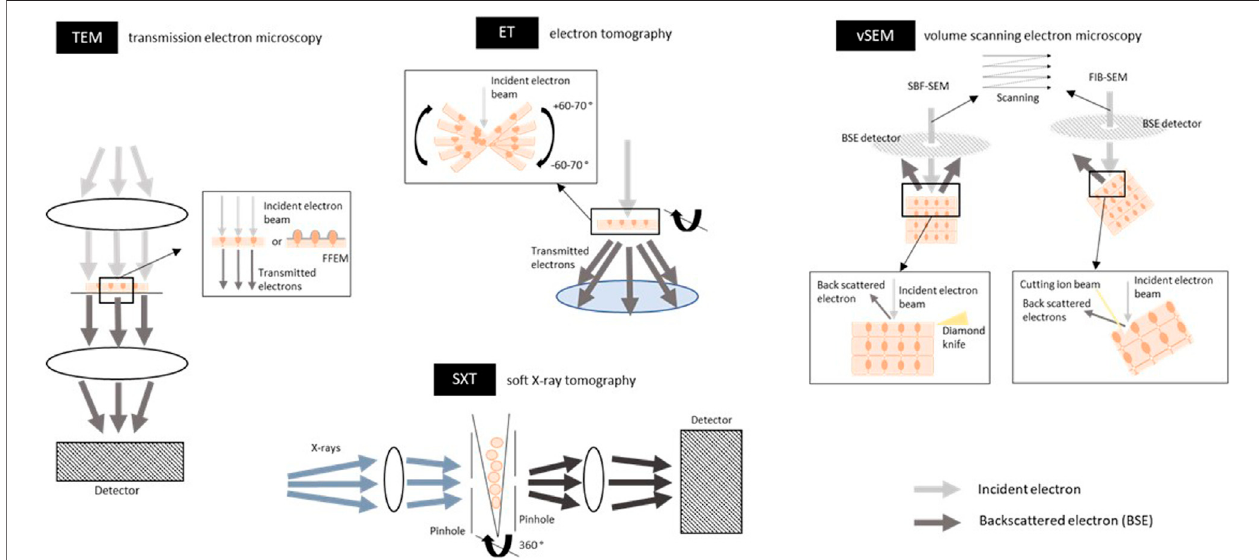
FIGURE 6 | Schematic overview of electron and X-ray based techniques for imaging the tight junctions, adherens junctions and desmosomes. Transmission electron microscopy (TEM) uses an electron beam that passes through the sample (thin sections of 60 – 80 nm of tissue or cultured cells; either fi xed or cryo-frozen because of vacuum conditions). The electron beam is absorbed and scattered by the sample which in their turn are captured on a detector and a contrast image of the sample can be seen. Electrons can only penetrate a very thin sample. In freeze fracture EM (FFEM) frozen biological samples are physically broken apart and platinum-carbon is used to replicate and contrast the fracture plane, which is then analyzed by TEM, exposing the intercellular junctions between cells. The lateral (xy) resolutionis2 nm.Foranexample ofanimage, see Figure4A .Electron tomography(ET)isanEM-derivedtechnique and isbasedonatiltseries of2Dimages acquired at different viewing angles, which are subsequently aligned and combined digitally into a 3D volume. Tilt series contain projections from a complete ±60 – 70 ° rotation of theobjecttoincludeprojectionsfromallpossibledirections.Thisgivesa3Dviewthroughthedepthofthespecimenatahighresolutionandtheintercellularjunctionscan bereconstructedin3D.Thesamplemustbethinsections(tissueorculturedcells;limitedtoabout300 nm; fi xedorcryo-frozen)torenderthemelectrontransparent.The lateral (xy) resolution is 2 nm. For an example of an image, Figure 4B . Volume scanning electron microscopy (volume-SEM) can image larger volumes with a greater sample depth compared to ET. The technique is based on the alternation between scanning the tissue surface with a focused electron beam followed by cutting off a section of the en-bloc tissue. The electron interact with the tissue surface and the backscattered electrons (BSE) are then detected by a detector. Cutting the section is donebyeitheradiamondknife[serialblockface(SBF)-SEM]oranionbeam[focusedionbeam(FIB)-SEM],enablingthecuttingofsectionswithathicknessof25 – 50and 5 nm respectively. The maximum sample width for SBF-SEM is around 1 mm and 20 – 100 µm width for FIB-SEM. The sample preparation often includes heavy metal staining for contrast, embedding in plastic resin and coating of the sample with a thin layer of conductive material (i.e. gold) to reduce the charging effects. The resulting 2D stack of images can be then 3D reconstructed to see the intercellular junction in a volume. The voxel resolution is up to 5 nm. For an example of an image, see Figure 4B . Soft x-ray tomography(SXT)uses soft X-raysasan illuminationlight source. Projections aretakenfrom different angles around a sample(cellsinsuspension oronagrid;cryo-frozen)byrotatingthesamplealongitslongaxis.SXTimagethesampleinthewaterwindow,meaningthatX-raysareabsorbedbycarbonandnitrogen in biological tissue more than by oxygen in water, resulting in grayscale that can be used for quantitative analysis. Soft X-rays have a limited penetration into the sample thus only samples of 10 – 20 µm can be imaged. The voxel resolution is 10 – 50 nm. Figures are not on scale.